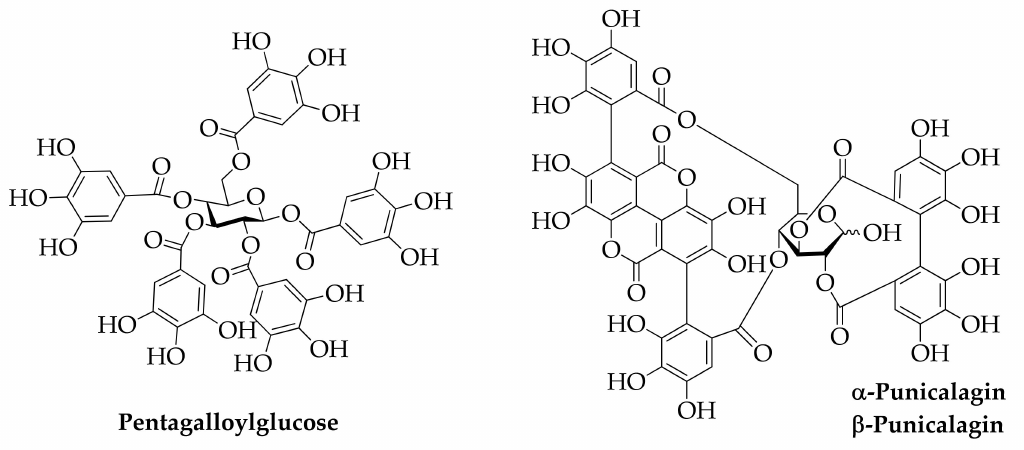
Figure 11. Hydrolysable tannins.